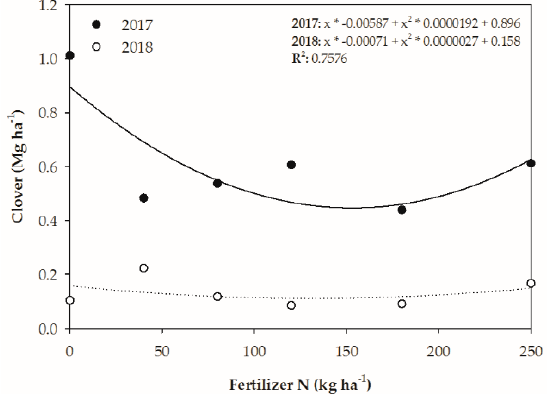
Figure 4. Response of stover yield to fertilizer nitrogen (N) rate for second-year maize in 2017 and 2018.